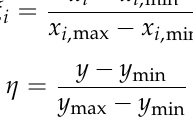
Table 1. The ranges of the inputs and the output in the raw data [12]. Inputs Output x